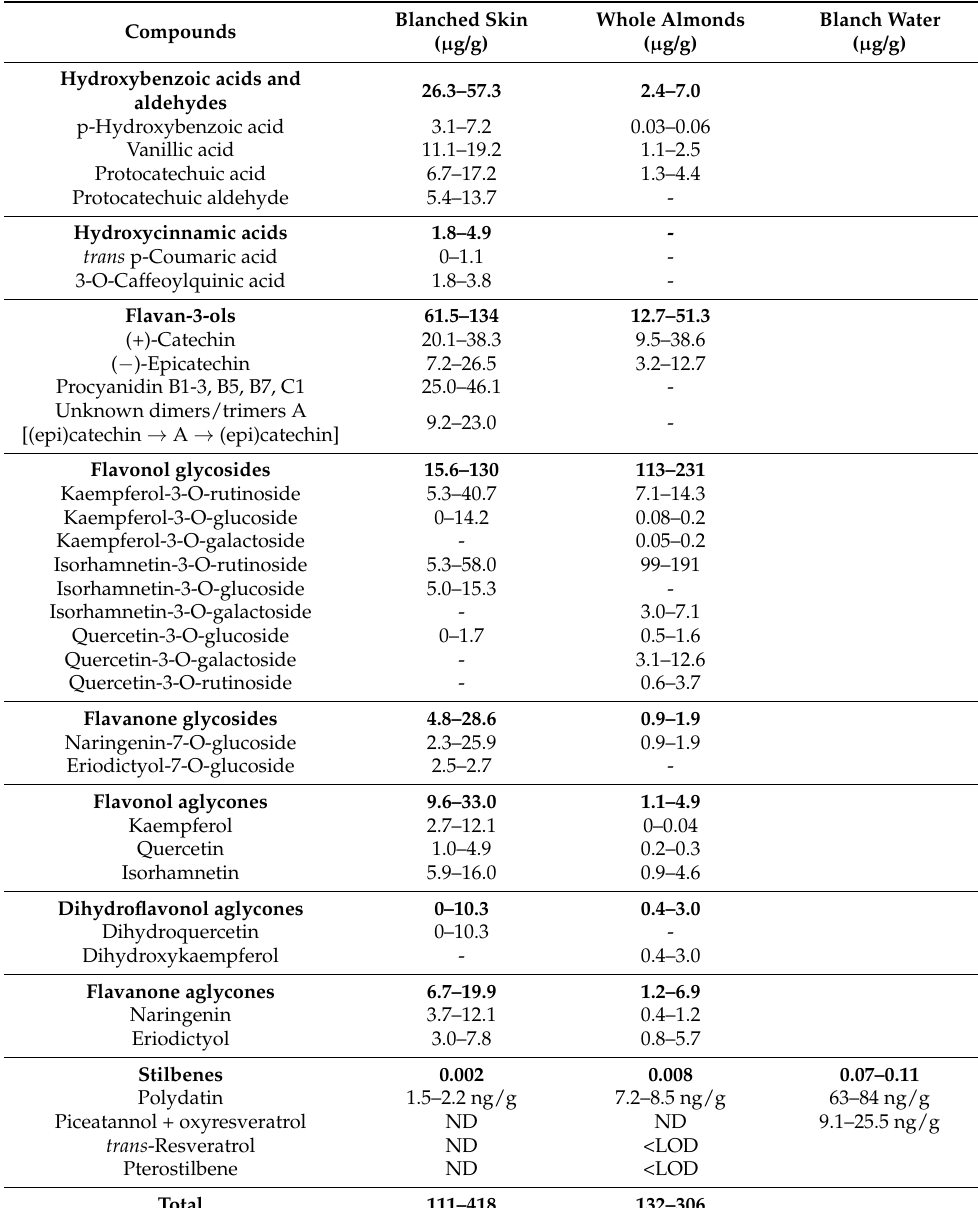
Table 2. Phenolic content in almond products and by-products. Quantitative data extracted from [4,14,20] 1